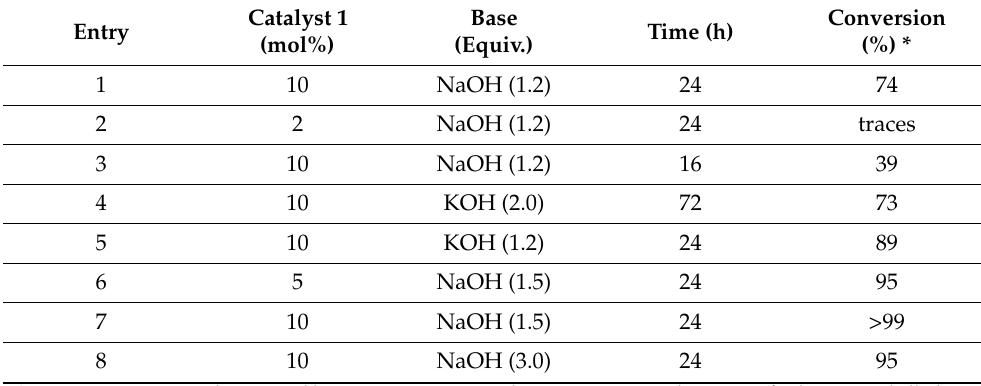
Table 3. Experimental data for the C-alkylation of substrate 17 with benzyl bromide in the presence of complex 1 .